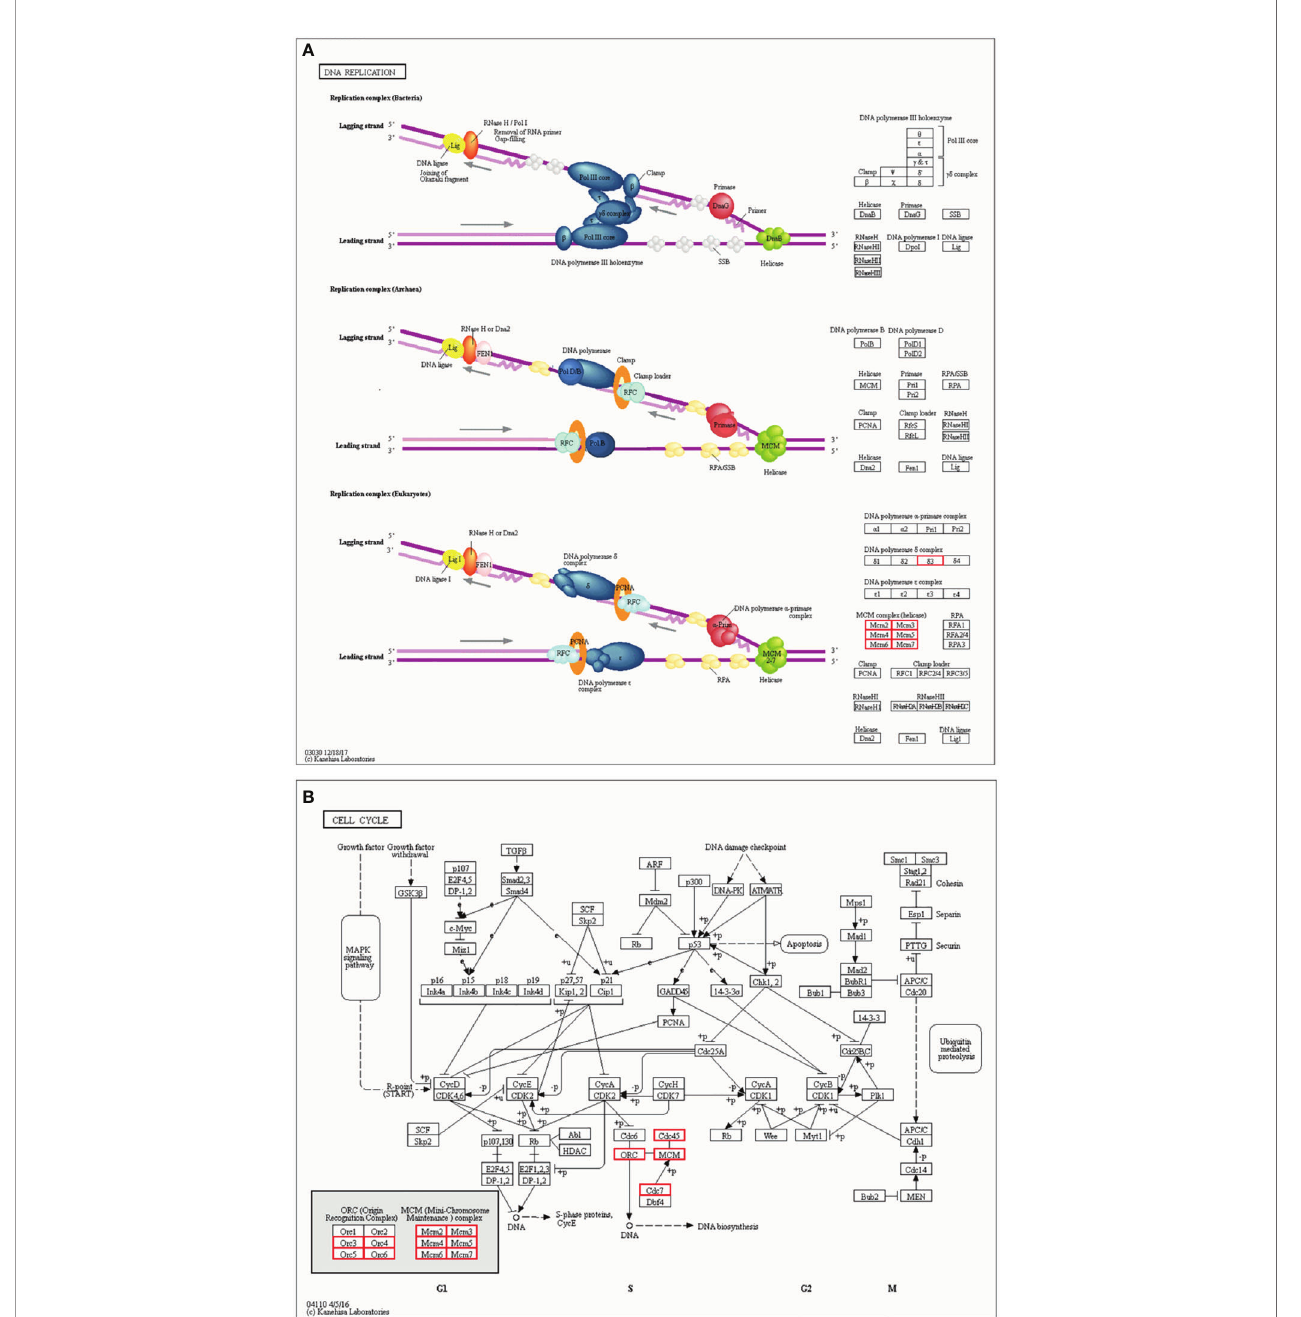
FIGURE 9 | KEGG pathway enrichment analysis (A) DNA replication terms based on the MCM complex and neighboring interaction genes. (B) Cell cycle terms based on the MCM complex and neighboring interaction